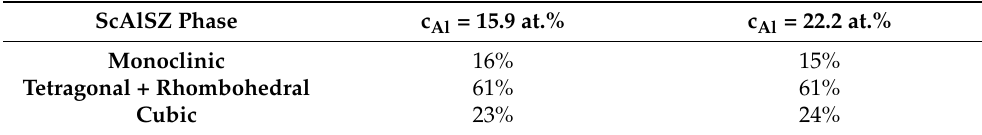
Table 5. Ratio of monoclinic, tetragonal and rhombohedral, and cubic phases of annealed ScAlSZ thin films.